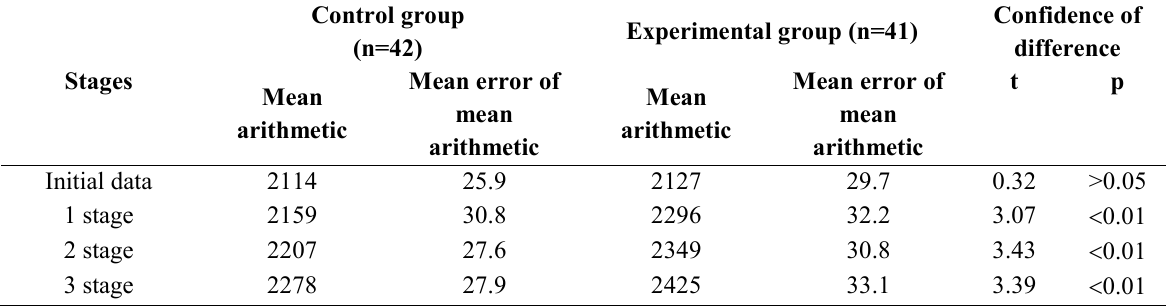
Table 3. Dynamic of Cooper’s test results in experimental and control groups during experiment, meters